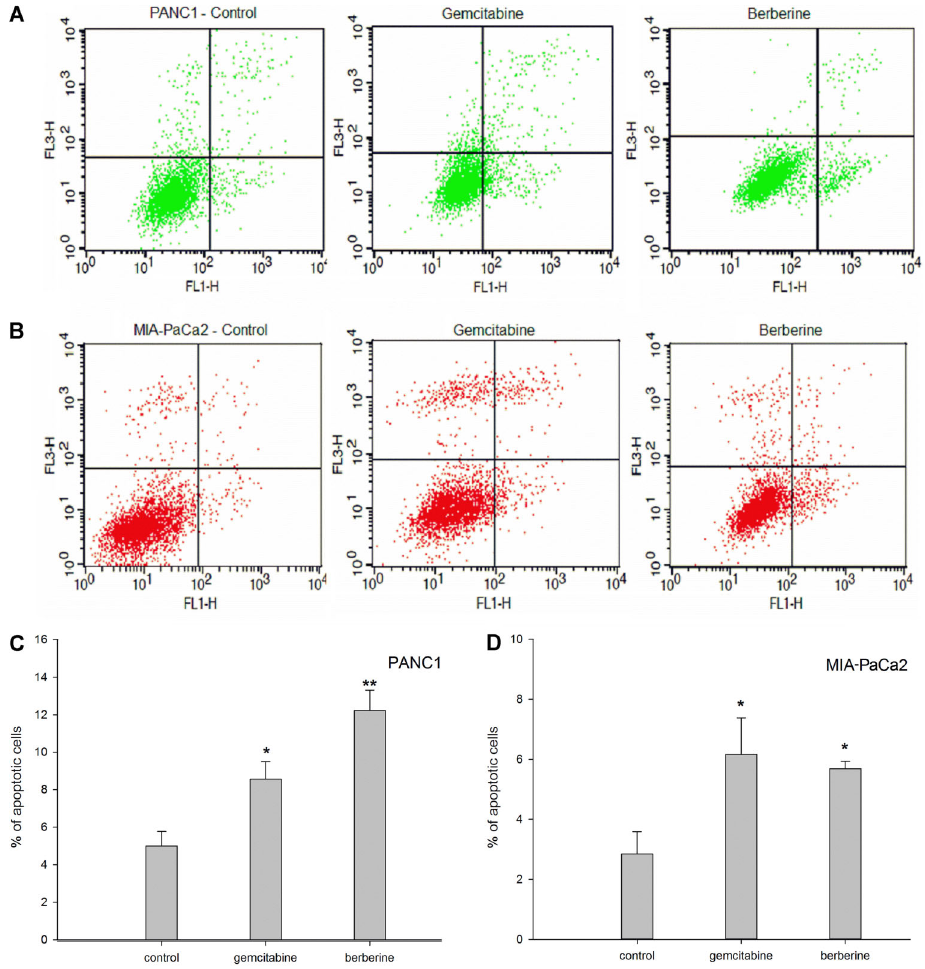
Figure 4. Annexin V staining after treatment with berberine and gemcitabine. A , PANC-1 cells were treated with distilled water (control), 15 m M berberine, or 10 nM gemcitabine for 72 h. B , MIA-PaCa2 cells were treated with distilled water, 10 m M berberine, or 7 nM gemcitabine for 72 h. C , PANC-1 cells were treated with distilled water, 15 m M berberine, or 10 nM gemcitabine for 72 h. D , MIA- PaCa2 cells were treated with distilled water, 10 m M berberine, or 7 nM gemcitabine for 72 h. All cells were stained with FITC- conjugated annexin V in a buffer containing PI and analyzed by flow cytometry. Data are reported as means±SD from a representative experiment (from a total of at least three). *P , 0.05, **P , 0.01 versus control (Student’s t